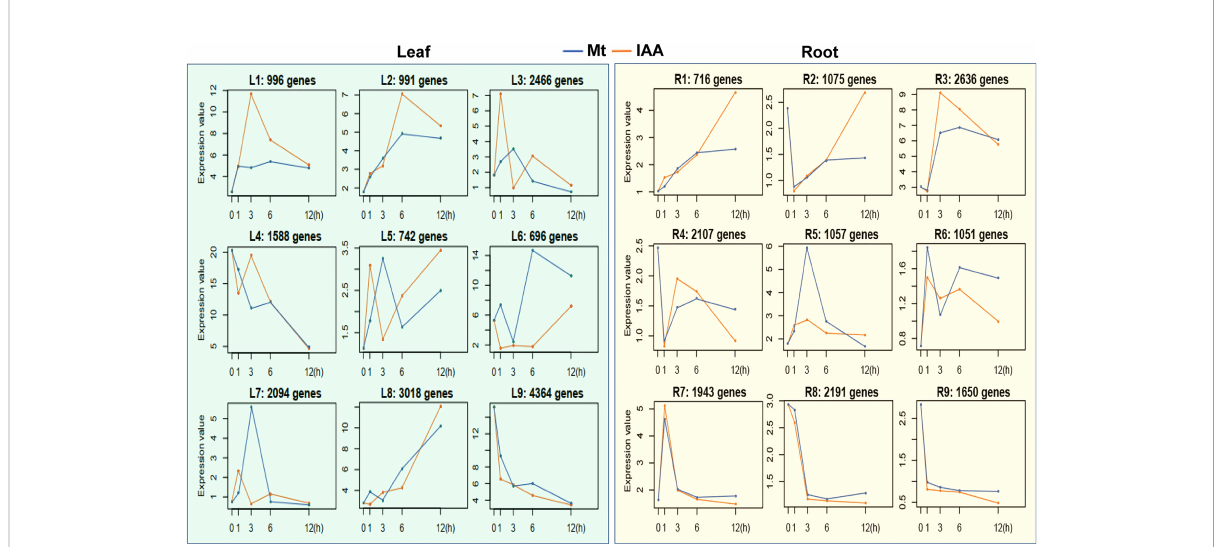
FIGURE 2 Time series analysis of DEGs in melatonin or auxin treated soybean seedlings. Common genes of melatonin (Mt) and auxin treatment in soybean seedlings were analyzed using a time series method. Each box indicates a cluster of genes. Blue lines indicate median pro fi les of the melatonin- responded genes, while orange lines indicate median pro fi les of auxin-responded